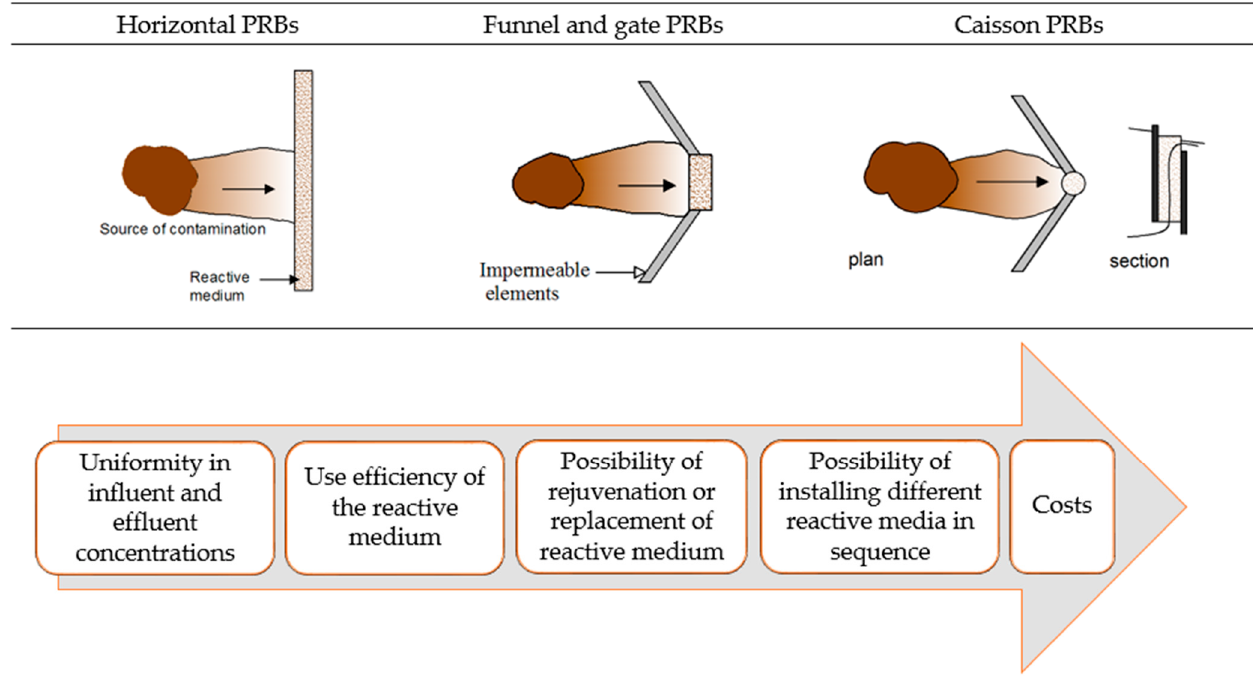
Figure 1. PRB configurations and their main characteristics.